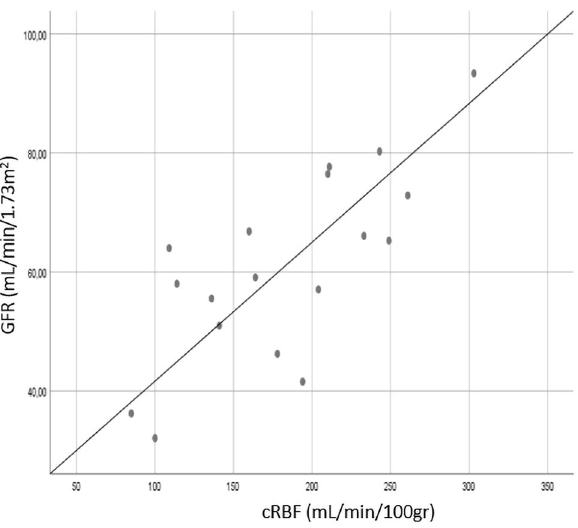
Figure 4. Scatter plot showing a positive correlation coefficient between cRBF and GFR; r = 0.75, p < 0.0001.